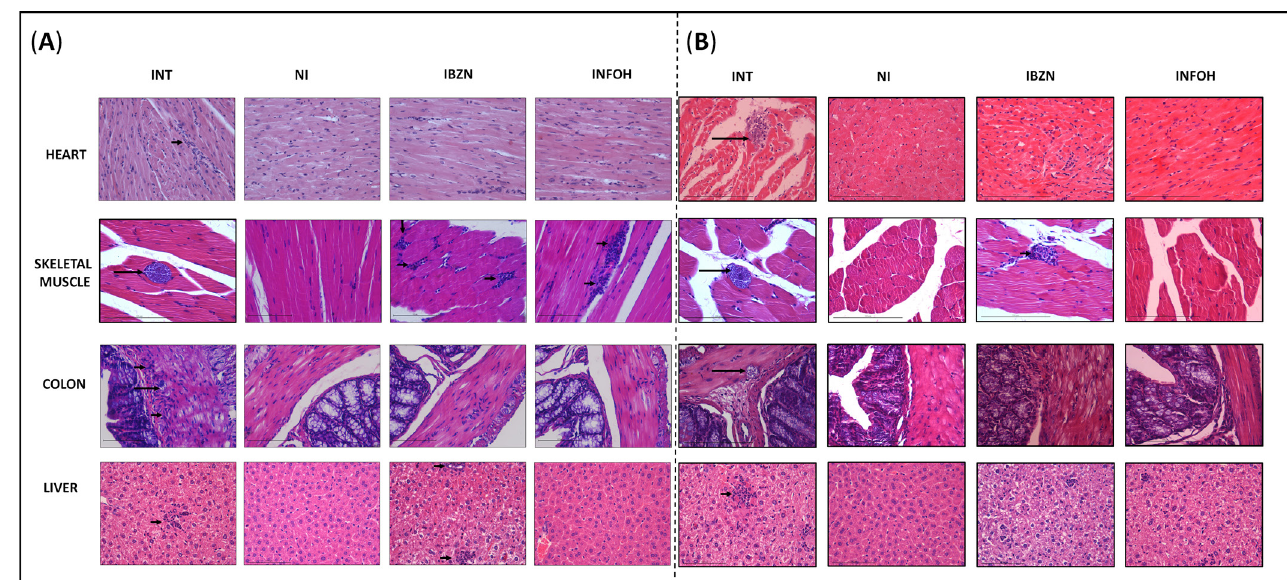
FIGURE 3 - Representative histopathological photography of the heart (H&E, 400X), skeletal muscle (H&E, 400X), colon (H&E, 400X), and liver (H&E, 400X) in two different murine models (Swiss and C57Bl/6). (A): Representative histopathological photography in Swiss mice; (B): Representative histopathological photography in C57Bl/6 mice; INT: infected and non-treated group, only vehicle; NI: non-infected group, only vehicle; IBZN: infected and treated with benznidazole; INFOH: infected and treated with hydroxymethylnitrofurazone; long arrows: presence of amastigote nest; short arrows: inflammatory